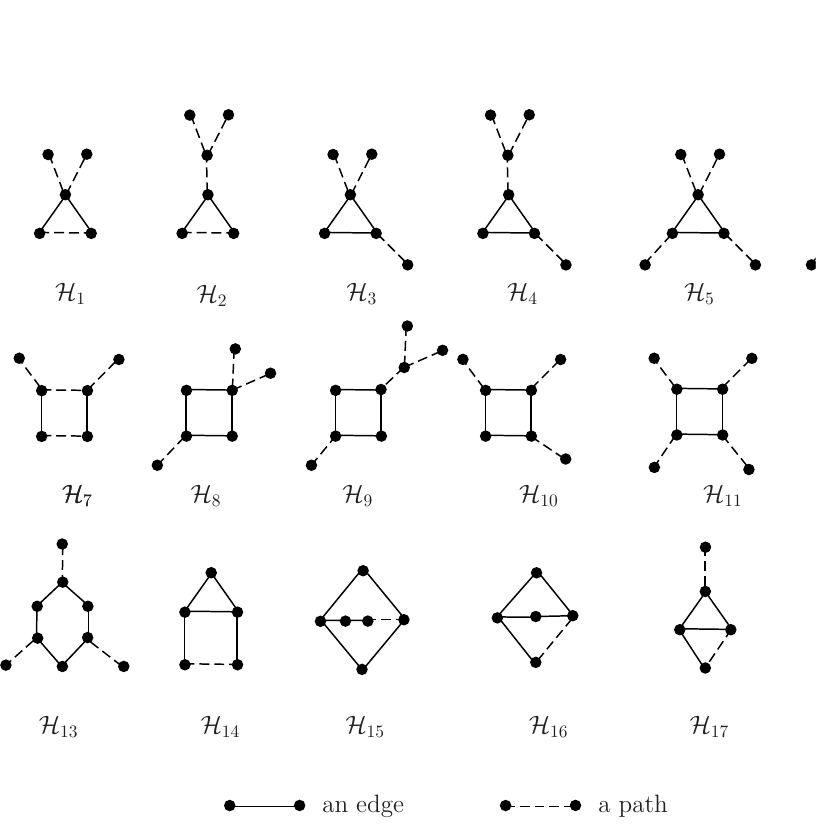
Fig 3: Graphs from Theorem